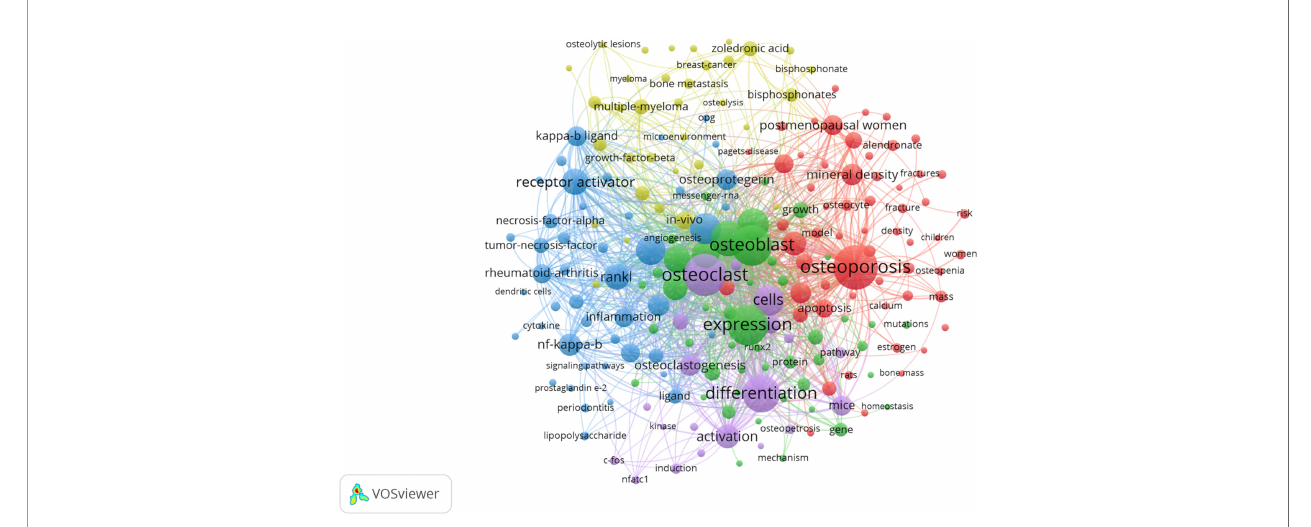
FIGURE 7 | Keyword co-occurrence network and clusters in osteoblasts-osteoclasts in bone disease. Notes: The size of the node and word re fl ects the co-occurrence frequencies, the link indicates the co-occurrence relationship, and the same node color represents the same cluster.